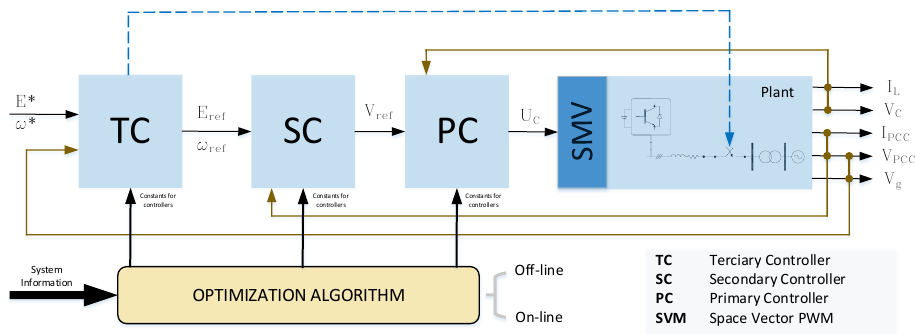
Figure 12. Optimization algorithm in